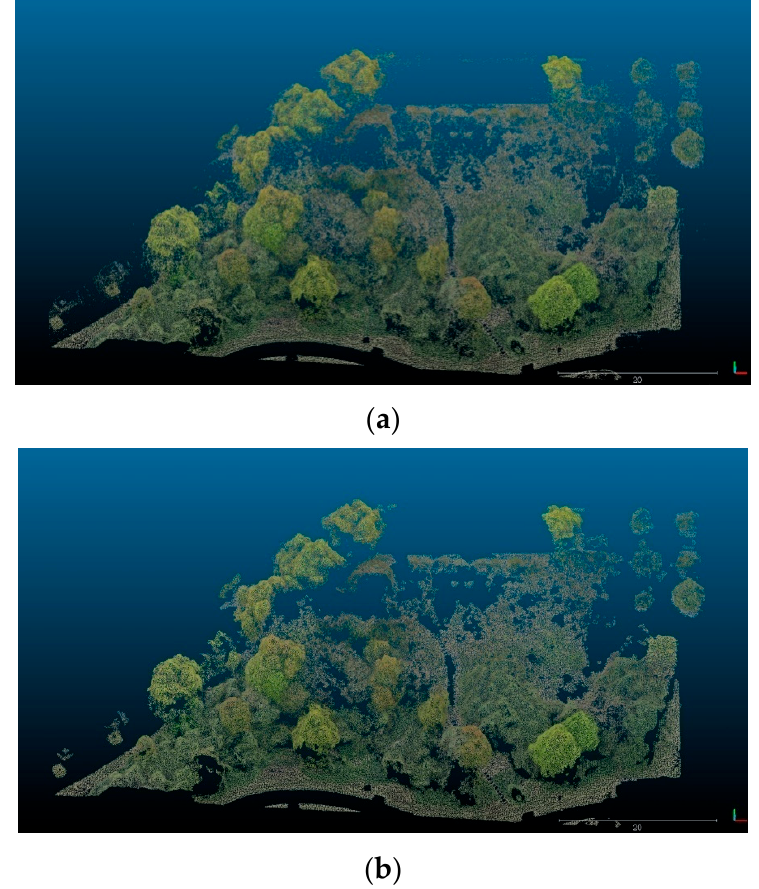
Figure 6. A comparison of the point cloud before and after being filtered by SOR filter. ( a ) Point cloud before filtering, ( b ) point cloud after filtering by SOR filter. The number of adjacent points was set to 50 and the standard deviation was set to 1.0.